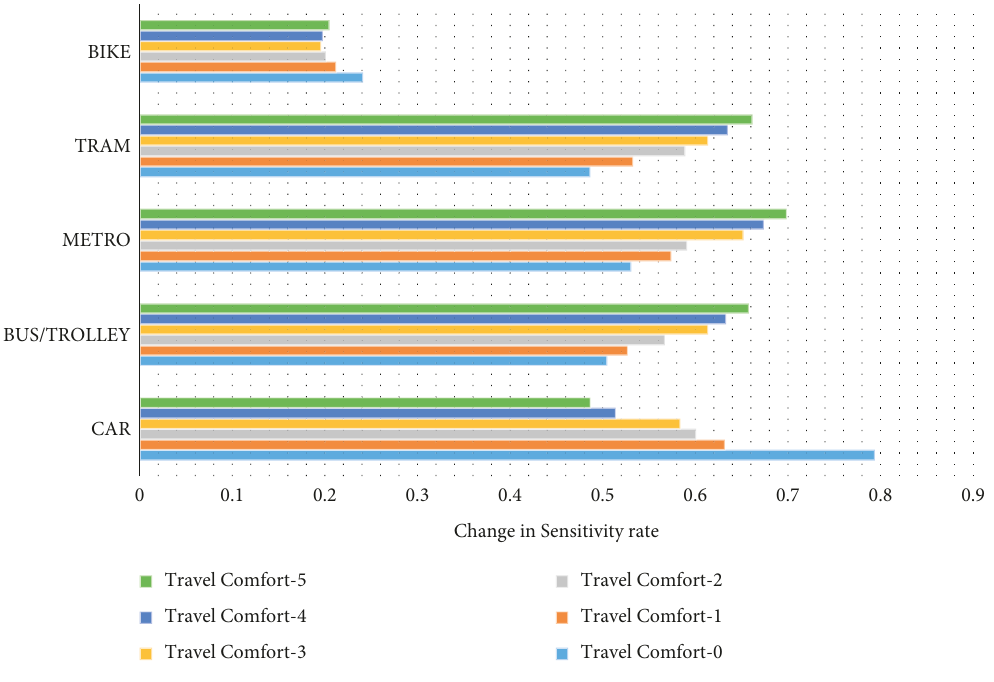
Figure 5: The values of the coefficients based on changing travel comfort.